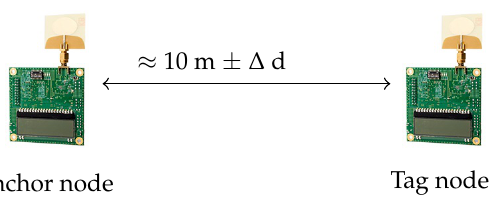
Figure 3. Schematic presentation of the experimental setup using the Decawave ranging